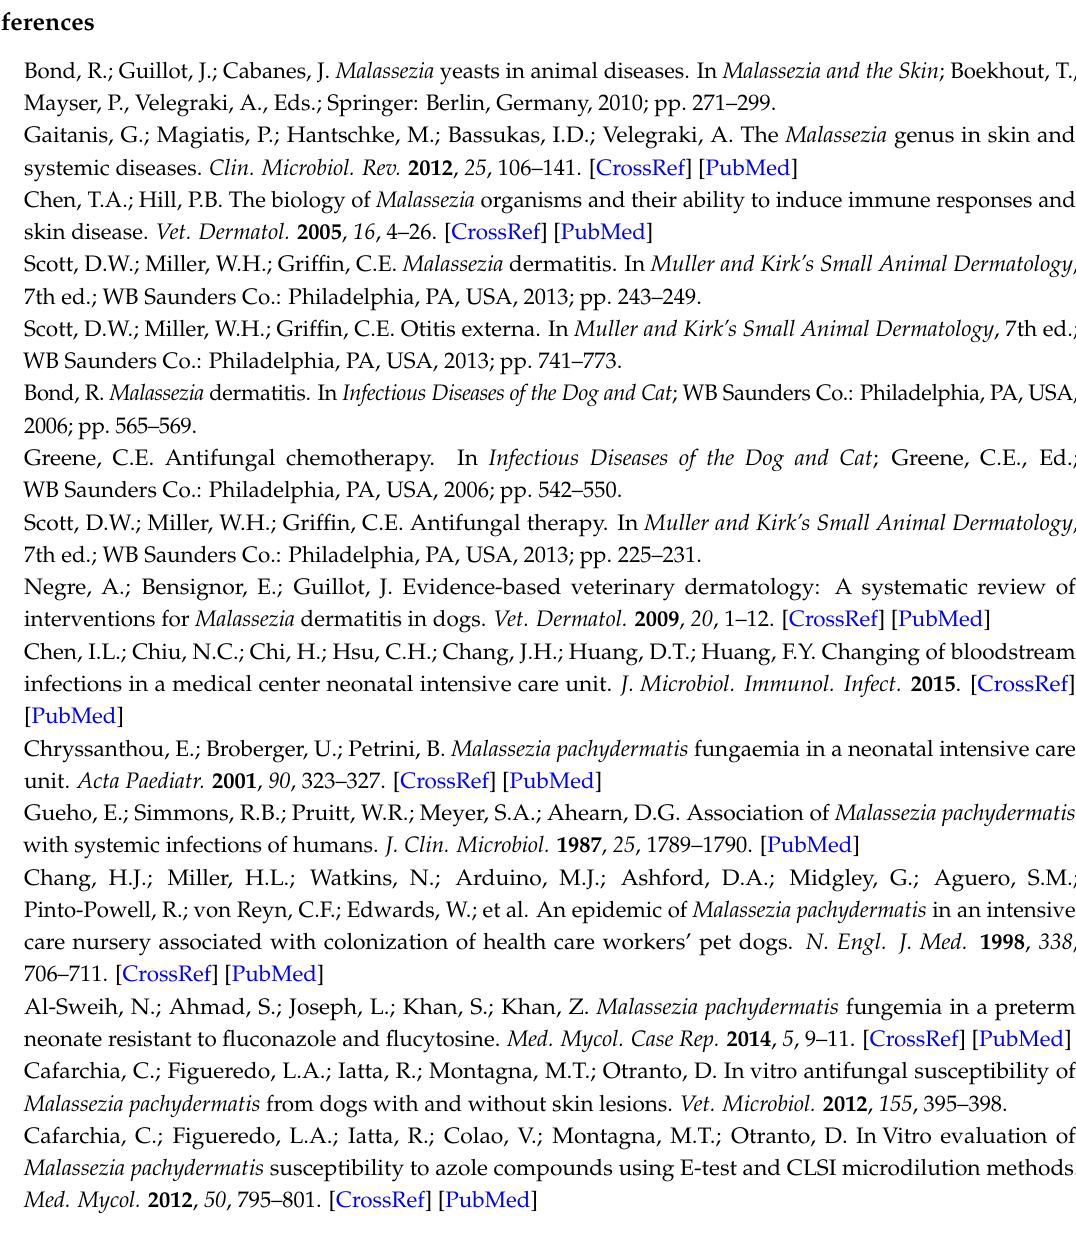
Table S1: Detailed description of previous studies concerned with in vitro susceptibility testing of M. pachydermatis (test format, test conditions, main results, etc.). Conflicts of Interest: The authors declare no conflict of